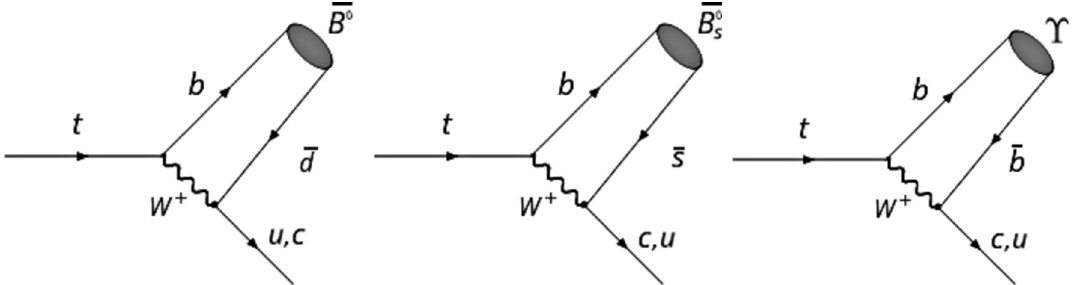
Figure 1 . Tree-level Feynman diagrams for the two-body top-quark decays t ! B 0 + u; c (left), t ! B 0 + c; u (center), and t ! (cid:7) + c; u (right). The quark ordering in the labels ( u; c or c; u ) s indicates the hierarchy of most probable decays, as computed